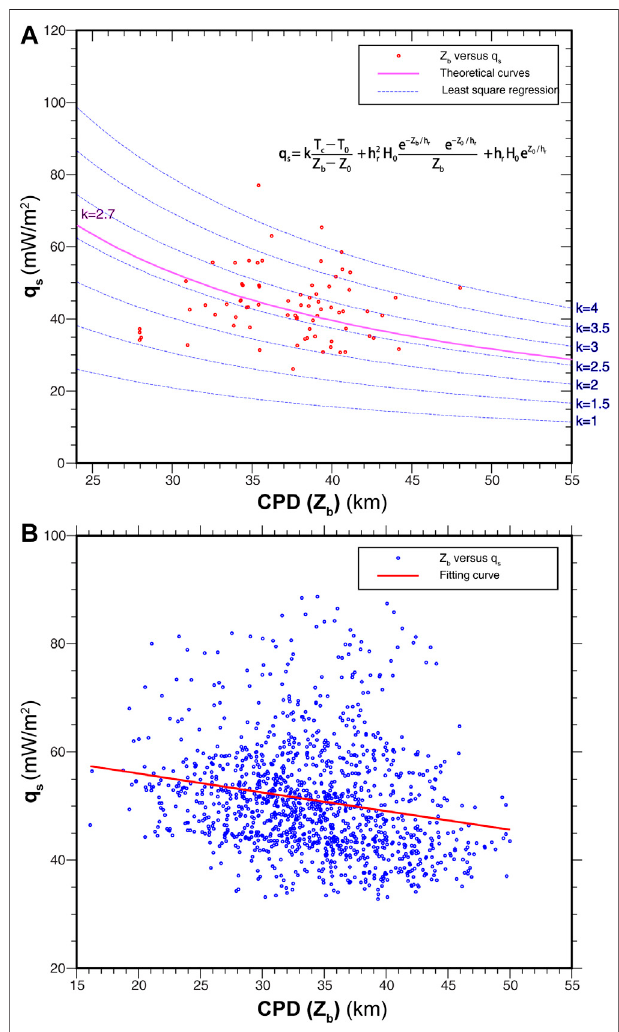
FIGURE 7 | (A) Inverse correlation between Curie Z b and surface heat fl ow points q s . Blue dashed curves are theoretical predictions with different thermalconductivities.Solidpinkcurveistheoptimal fi ttingmodel(intheleast- squares sense) for heat fl ow, which gives k (cid:2) 2.7 W/(m ° C), H 0 (cid:2) 3 μ W/m 3 , and H r (cid:2) 10 km. (B) The Curie depth points estimated from 1,274 moving windows and the corresponding points of heat fl ow. The solid red line is the linear trends of correlations between Curie Z b and surface heat fl ow points q s